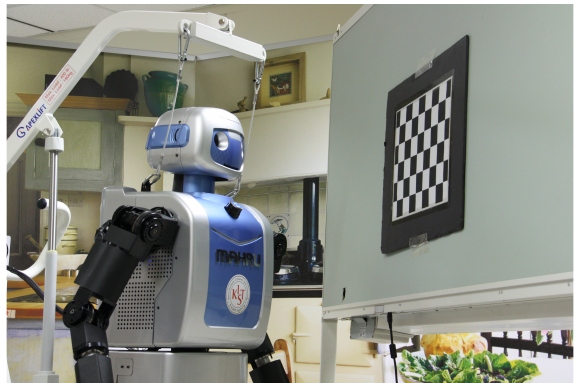
Figure 17. Real experimental setup: A calibration board and a stereo camera mounted on the humanoid robot,